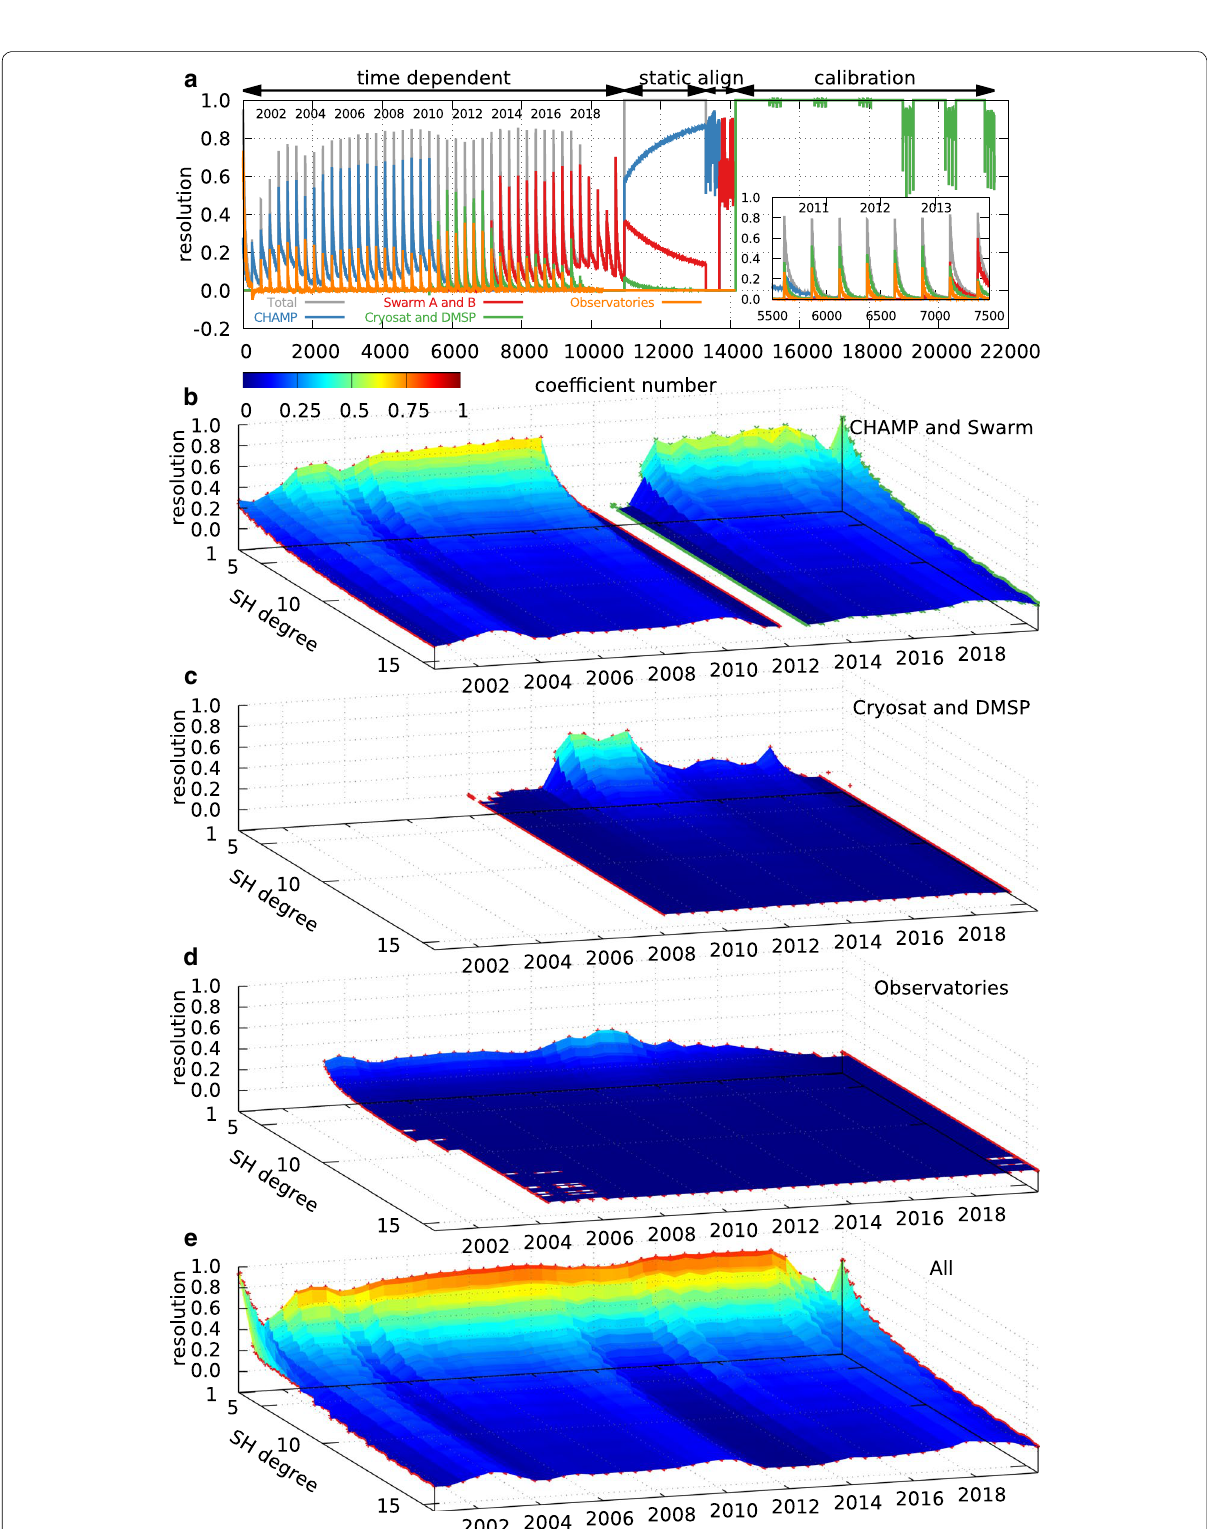
Fig. 10 a Diagonal entries of resolution matrices for Model A, separated by satellite dataset and plotted versus coefficient number from 1 to 21,605. Inset zoom view shows the resolution of the coefficient range approximately corresponding to the gap period between CHAMP and Swarm. The lower panels show the diagonal entries of the resolution matrices for the time-varying internal field portion versus spherical harmonic degree and time for b CHAMP (left) and Swarm (right), c Cryosat and DMSP, d ground observatories, and e all data